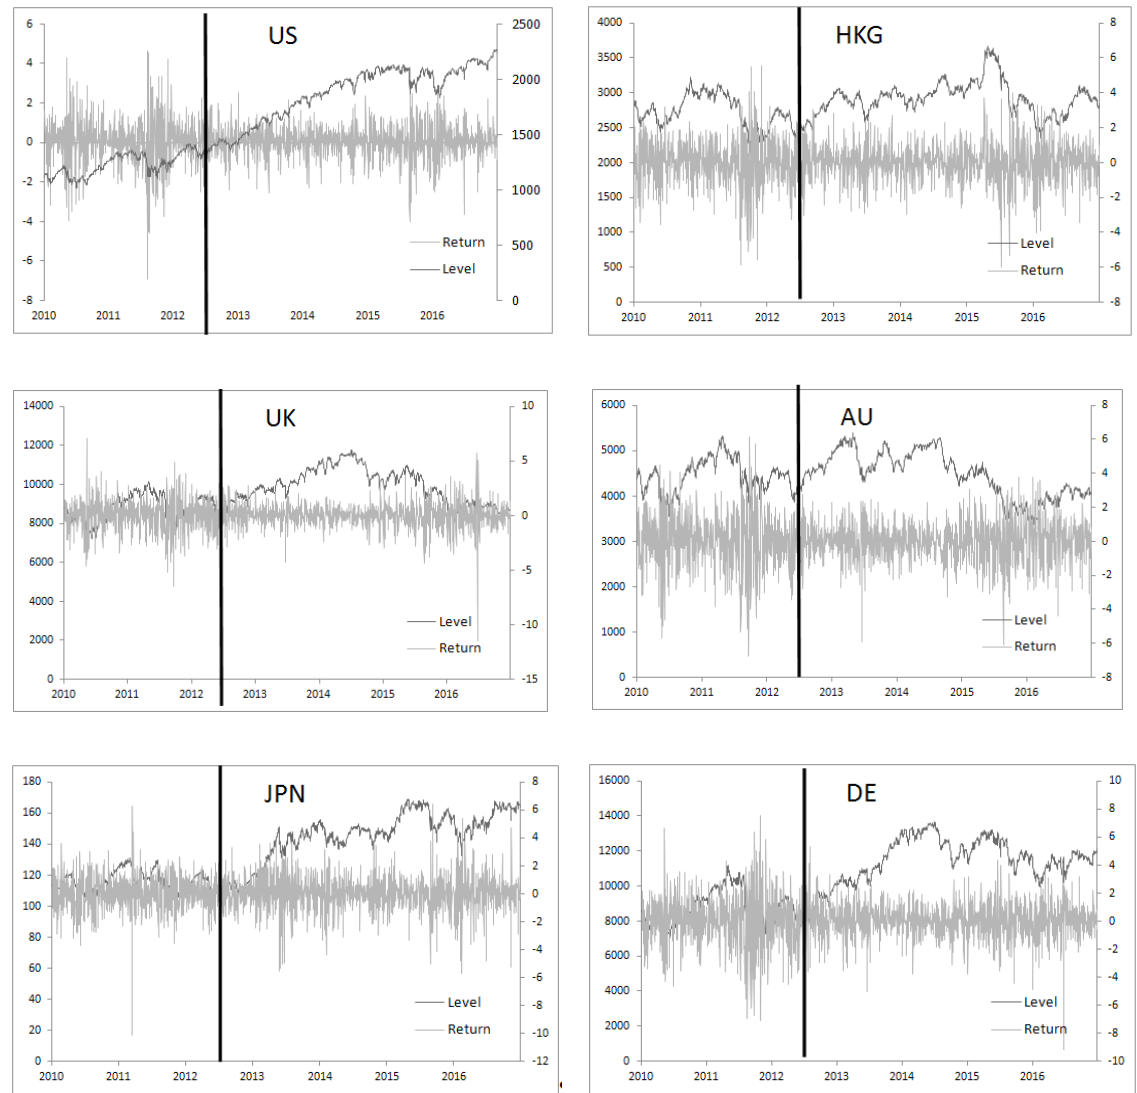
Figure 1. Index level and return series